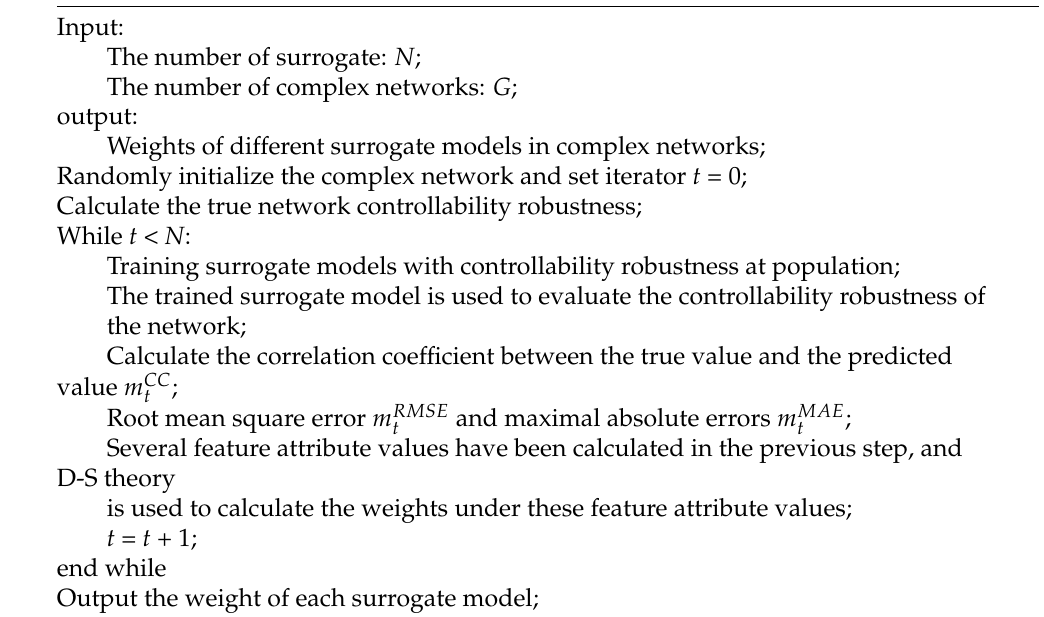
Algorithm 2: The process of calculating the weights of D-S